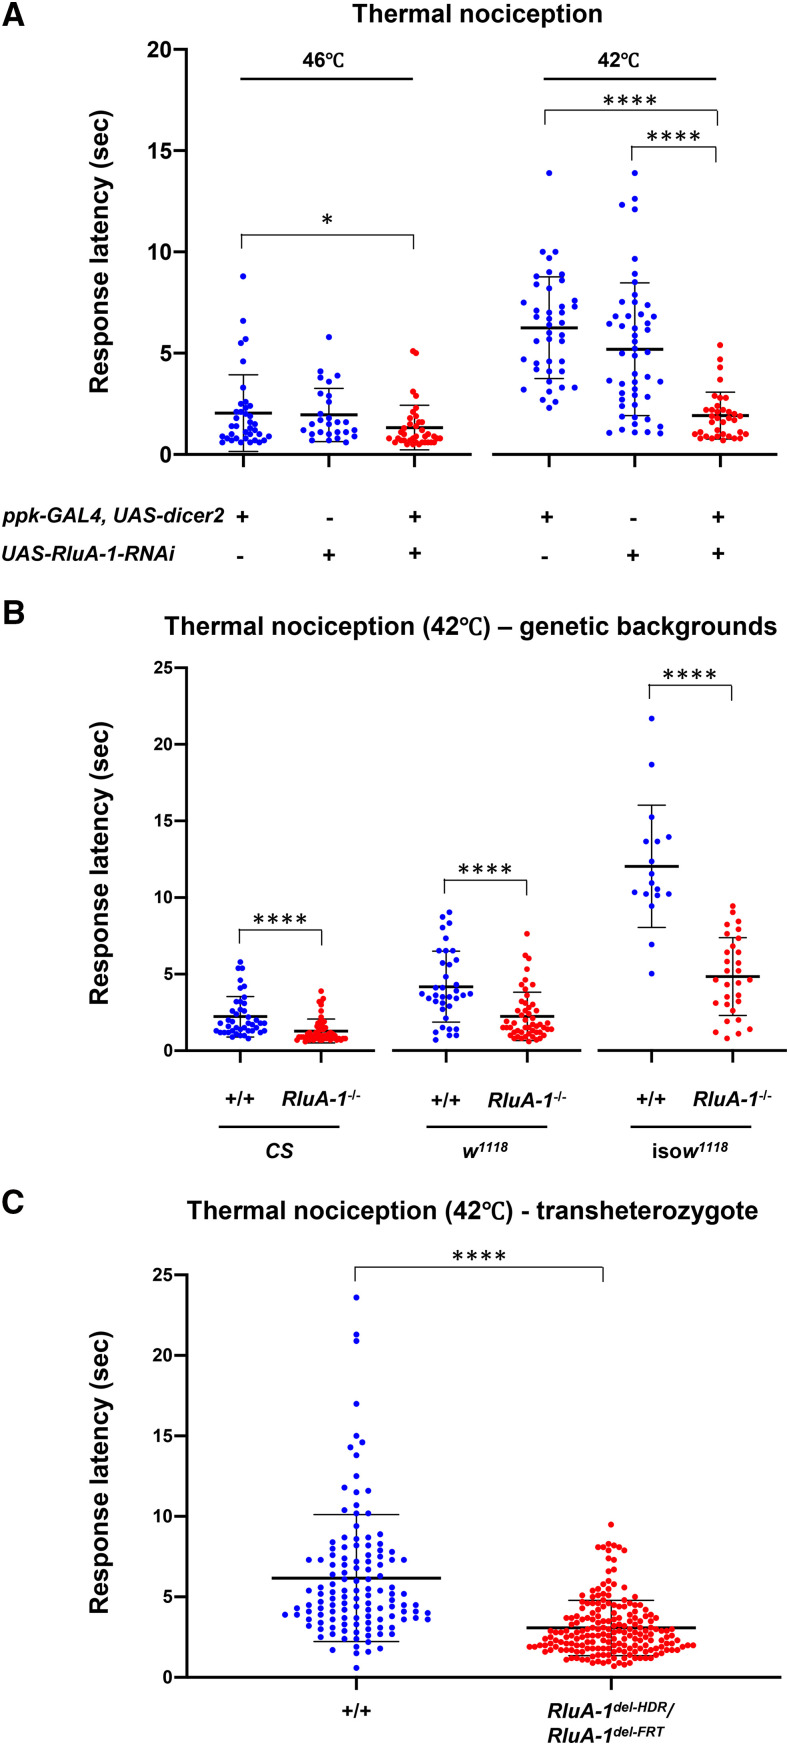
Thermal nociception in animals with RluA-1 loss of function. (A). Class IV specific knock-down in RluA-1 results in significant hypersensitive thermal nociception in larvae compared to the ppk-GAL4 driver alone animals at 46° (average latency of 1.33 ± 1.10 sec for ppk-Gal4 > UAS-RluA-1-RNAi (31719-R1), n = 38 vs. 2.04 ± 1.89 sec for ppk-GAL4 driver alone, n = 37. P < 0.05), albeit not statistically significant compared to the UAS-RluA-1RNAi alone (1.96 ± 1.32 sec for UAS-RluA-1RNAi alone, n = 27). These differences are more pronounced at 42° (average latency of 1.92 ± 1.16 sec for ppk-Gal4 > UAS-RluA-1-RNAi, n = 35 vs. 6.25 ± 2.51 sec for ppk-GAL4 driver alone controls, n = 42 or 5.20 ± 3.28 sec for UAS-RluA-1RNAi alone controls, n = 49, P < 0.0001). Kruskal-Wallis test with Dunn’s multiple comparison tests, only significant comparisons were labeled. (B). Homozygous null mutant RluA-1del-HDR larvae showed significantly faster response to noxious heat stimulation of 42° compared to the corresponding control animals of Canton-S (average latency of 1.29 ± 0.78 sec in RluA-1−/−, n = 54 vs. 2.22 ± 1.32 sec in CS, n = 39), w1118 (2.23 ± 1.57 sec in RluA-1−/−, n = 51 vs. 4.16 ± 2.31 sec in w1118, n = 36) and isow1118 (4.82 ± 2.53 sec in RluA-1−/−, n = 30 vs. 11.99 ± 3.98 sec in isow1118, n = 17). Significance of comparisons are marked as **** (P < 0.0001). Data were analyzed using Mann-Whitney non-parametric test. (C). Transheterozygote RluA-1del-HDR/RluA-1del-FRT showed hypersensitive thermal nociception responses compared to the controls (average latency of 3.07 ± 1.72 sec in RluA-1del-HDR/RluA-1del-FRT, n = 195 vs. 6.17 ± 3.95 sec in +/+, n = 125). The genetic background is w1118 for RluA-1del-HDR, and isow1118 for RluA-1del-FRT. For the RluA-1del-HDR/RluA-1del-FRT transheterozygotes, data were pooled from the progeny from reciprocal crosses of RluA-1del-HDR to RluA-1del-FRT. To generate the control larvae, reciprocal crosses were made between the genetic background of w1118 and isow1118 and the data from the progeny of these crosses were pooled. Significance of the comparison is marked as **** (exact P < 0.0001). Data were analyzed using Mann-Whitney U-test. Error bars in all the figures represent S.D.